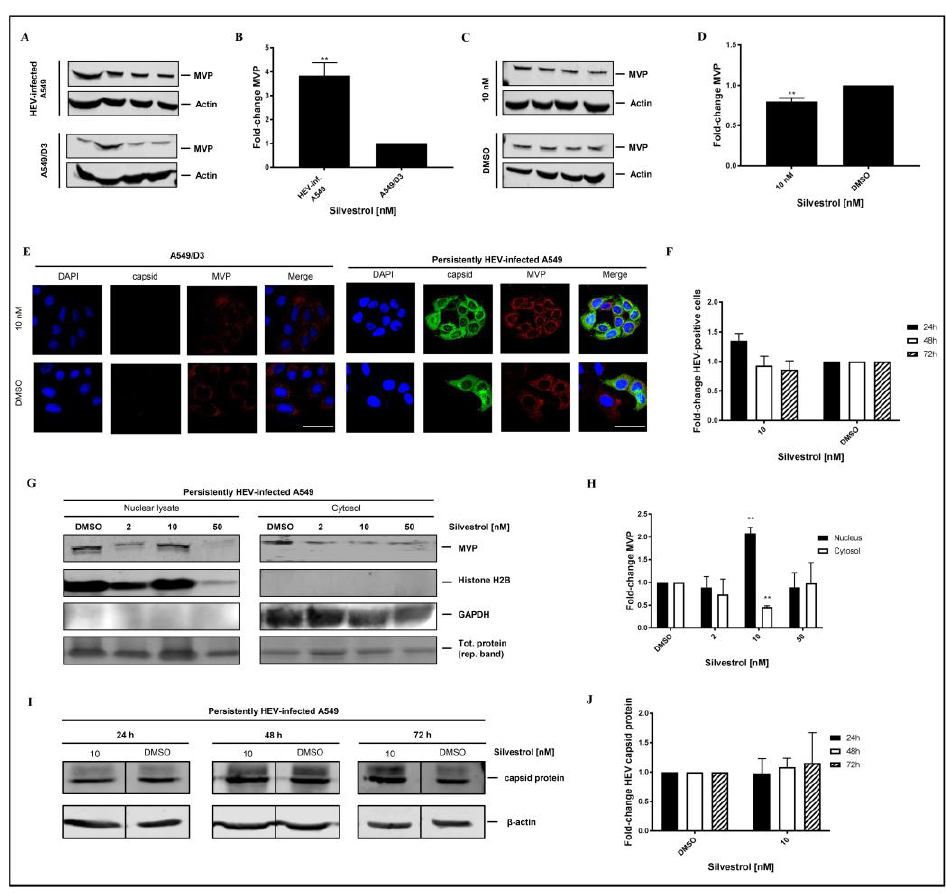
Figure 8. MVP is upregulated in HEV-infected A549 cells and is downregulated and translocated to the perinuclear region upon 10 nM silvestrol treatment. ( A ) Western Blot analysis of cellular lysates derived from persistently HEV-infected A549 cells as compared to A549/D3. An MVP-specific antibody was used for detection, detection of beta-actin served as loading control. ( B ) Shows the corresponding quantification of ( A ) normalized to beta-actin. n = 4; ** p < 0.01. ( C ) Western Blot analysis of cellular lysates derived from persistently HEV-infected A549 cells treated with 10 nM silvestrol for 24 h. Treatment with DMSO served as a control. ( D ) Shows the corresponding quantification of ( C ) normalized to beta-actin. n = 4; ** p < 0.01. ( E ) A549/D3 and persistently HEV-infected A549 cells were seeded on cover-slips and treated with 10 nM silvestrol for 24 h. Nuclei were stained with DAPI (blue), HEV capsid protein-specific antibodies (green) and MVP-specific antibodies (red) were used for detection. ( F ) Comparison of the proportion of HEV capsid protein expressing cells after treatment with 10 nM silvestrol depicted in ( E ) to the respective DMSO control; n = 3, scale bar = 40 µ m ( G ) Western Blot analysis of nuclear lysates and cytosolic protein fraction after subcellular fractionation of HEV-infected A549 cells treated with silvestrol; Histone H2B and ERK1 served as control for nuclei and cytoplasm. ( H ) Normalized Quantification of MVP detected in ( G ); n = 3; ** p < 0.01. ( I ) Representative Western Blot of cellular lysates derived from cells treated with 10 nM silvestrol. DMSO treatment served as control. For detection, a capsid-protein specific antiserum and a beta-actin-specific antibody for loading control were used. ( J ) Relative quantification of Western Blot band intensities of ( I ) normalized to intracellular beta-actin levels, referred to the DMSO control; n =